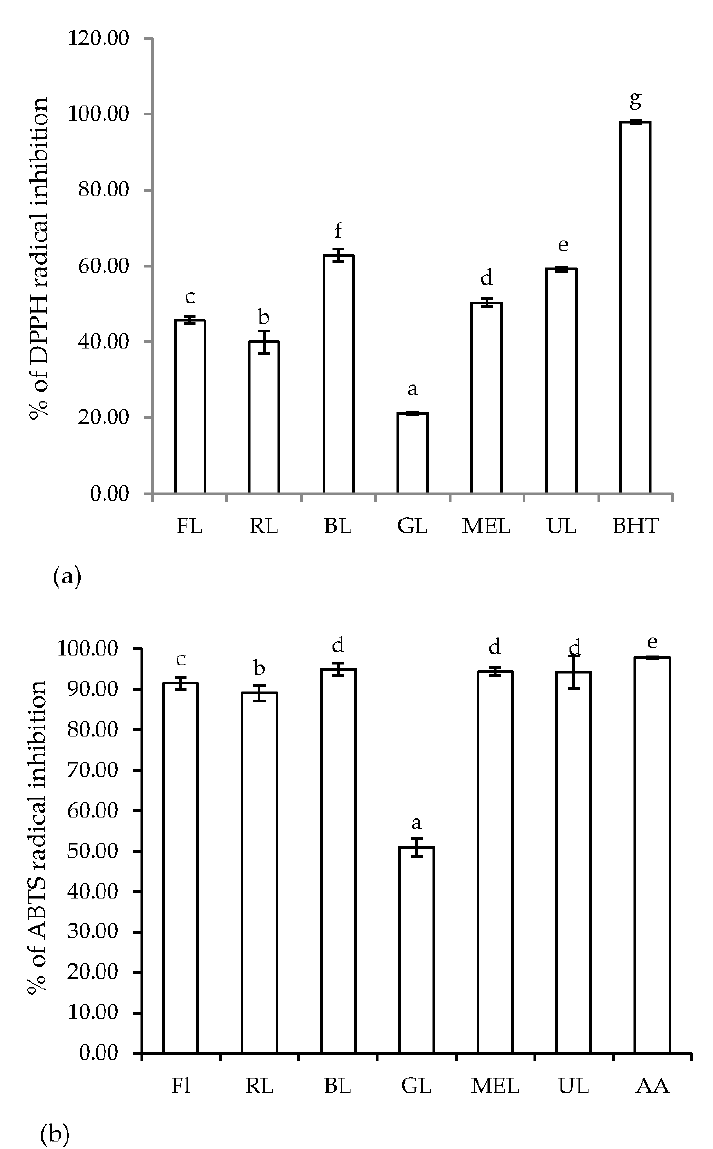
Figure 4. Antioxidant capacity of peanut sprouts grown under different light qualities. ( a ) 1,1-Diphenyl-2-picrylhydrazyl (DPPH) radical scavenging activity. ( b ) 2,2-Azino-bis 3-ethylbenzothiazoline-6-sulfonic acid (ABTS) radical scavenging activity. FL: fluorescent light, RL: red LED, BL: blue LED, GL: green LED, MEL: micro-electrodeless light, UL: ultrasound+ FL, AA: ascorbic acid, and BHT: butylated hydroxytoluene. Mean values within a column with the same lowercase letters were not significantly different ( p < 0.05), according to Duncan’s multiple comparison test. Data are means ± standard deviation ( n = 3). Means with different small letters, respectively, indicate a significant difference at p <.0.05